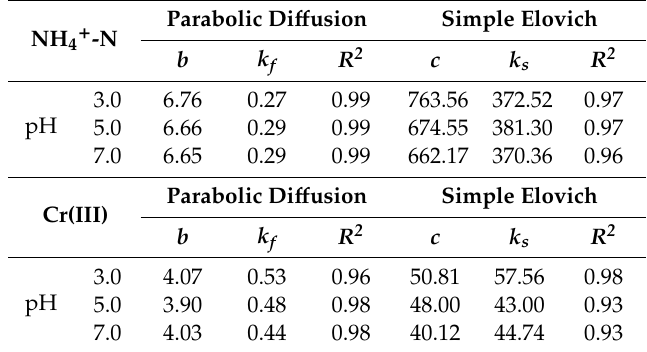
Table 3. Kinetic model fitting parameters for Cr(III) and NH 4 + -N released from tannery sludge.